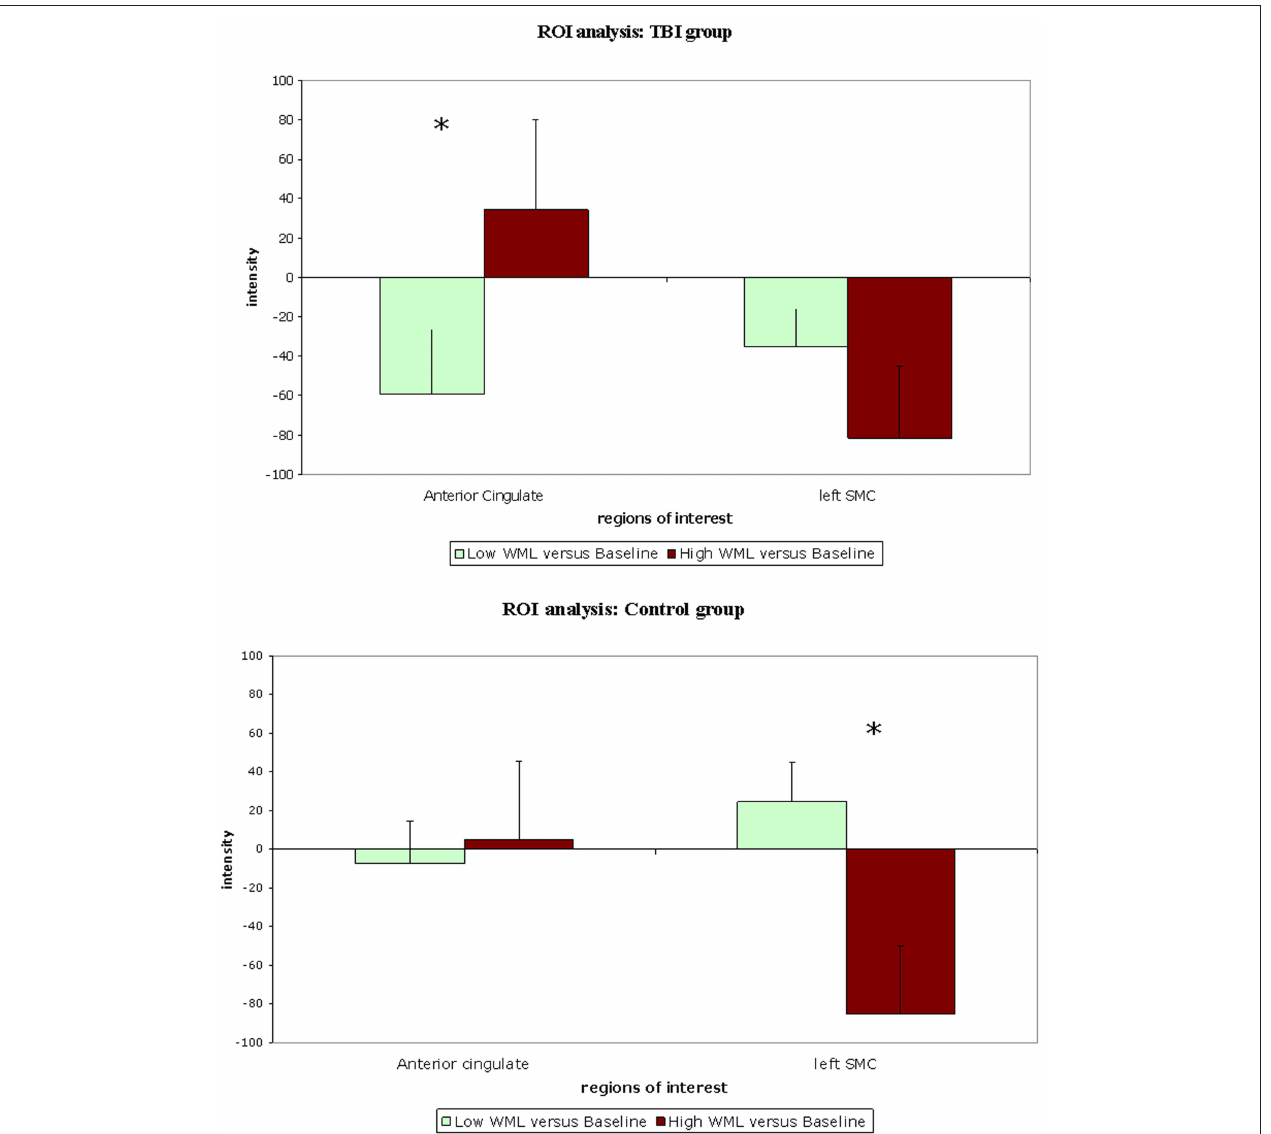
FIguRe 3 | Comparison of activation in regions of interest for “Low WML” (green) and “High WML” (brown) contrasts in traumatic brain injury group and Control group respectively.